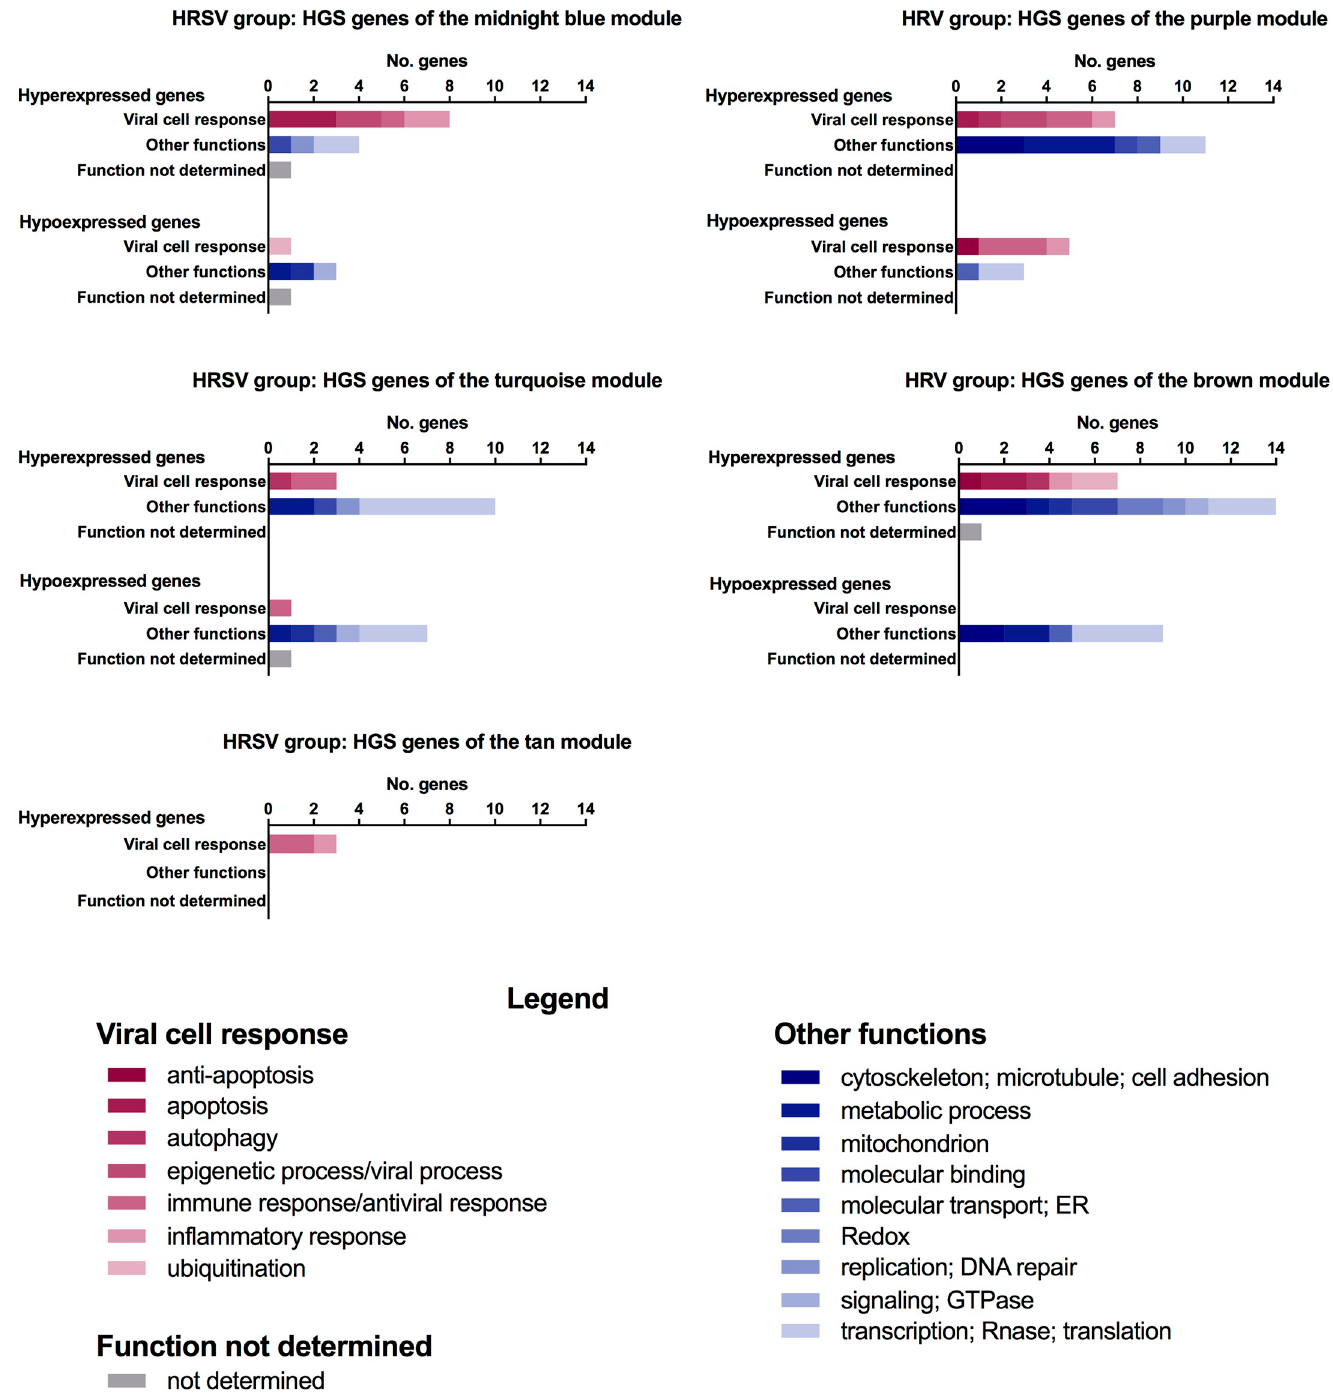
Fig 4. Functional profile of the HGS-hub genes. Biological function categorization and distribution of HGS-hubs in the five modules positively associated with HRSV or HRV groups.